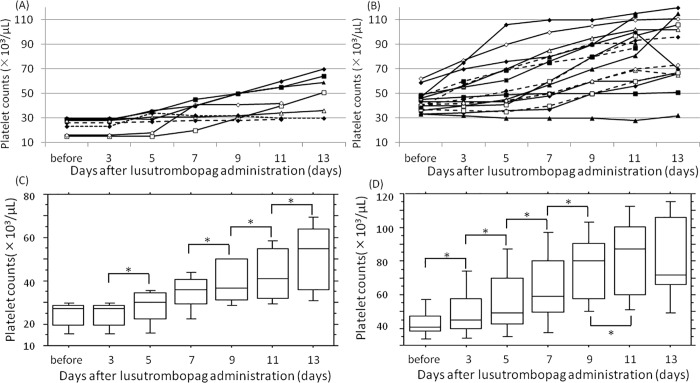
Changes in platelet counts after lusutrombopag therapy and prior to the invasive procedures.(A) Patients with baseline platelet count ≤30,000/μL. (B) Patients with baseline platelet count >30,000/μL. (C) Patients with baseline platelet count ≤30,000/μL. Platelet counts in patients with a baseline platelet count ≤30,000/μL were 24±5.9 at baseline which increased to 24±5.9, 28±7.8, 35±8.3, 39±9.8, 43±1.2, and 52±1.6 ×103/μL at 3, 5, 7, 9, 11, and 13 days after administration, respectively. *: p<0.05. (D) Patients with baseline platelet count >30,000/μL. Platelet counts in patients with a baseline platelet count >30,000/μL were 43±8.0 at baseline which increased to 50±1.4, 57±2.1, 64±2.2, 74±2.2, 81±2.5, and 82±2.7 ×103/μL at 3, 5, 7, 9, 11, and 13 days after administration, respectively. *: p<0.05.